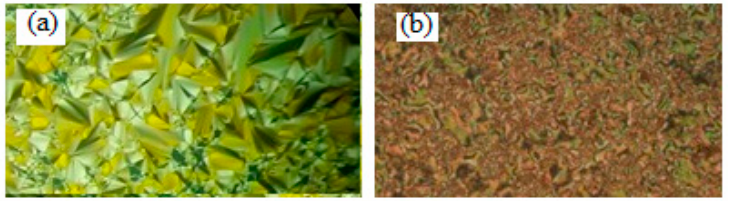
Figure 4. Smectic phases’ textures upon cooling under POM for complex Ic/II ( a ) SmA phase at 44.0 °C and ( b ) SmC phase at 25.0 °C. Table 1. Phase transition temperatures ( T , °C), enthalpy of transitions ( ∆ H , kJ/mol), and normalized transition entropy ( ∆ S ) of supramolecular complexes Ix/II .